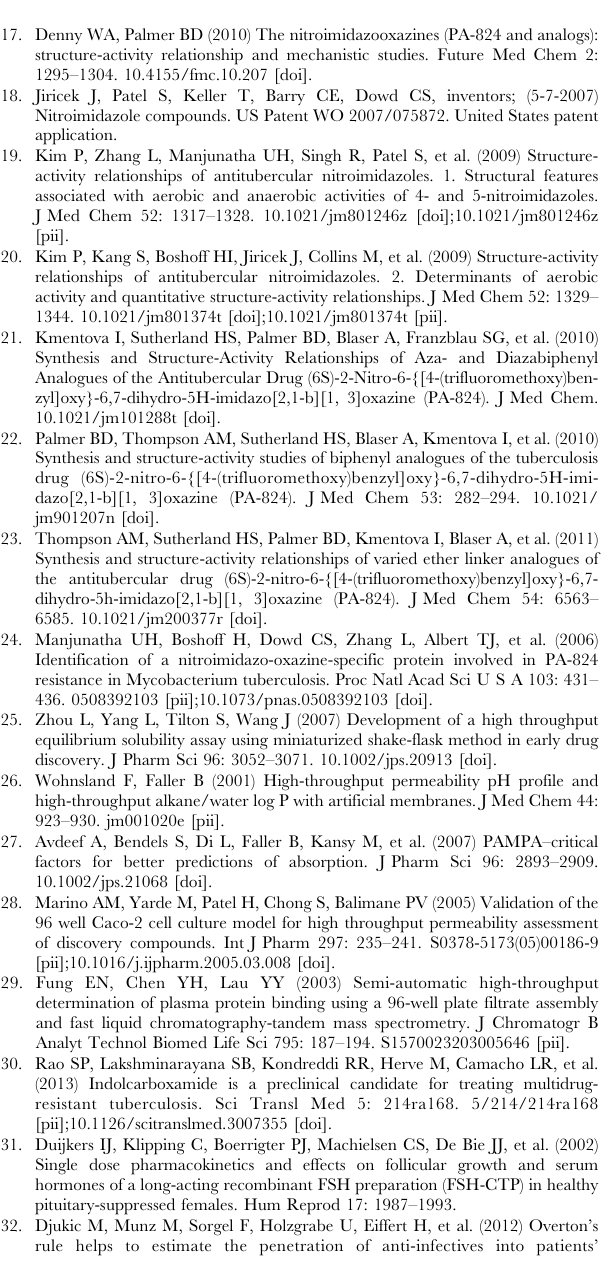
File S1 Figure S1: Plasma concentration time profile for repre- sentative bicyclic 4-nitroimidazole analogs following a single 25 mg/kg oral dose in mice. Table S1: Correlation of PK parameters with in vivo efficacy in mice for bicyclic 4-nitroimi- dazole analogs. Table S2: Correlation of PK-PD indices with in vivo efficacy in mice for bicyclic 4-nitroimidazole